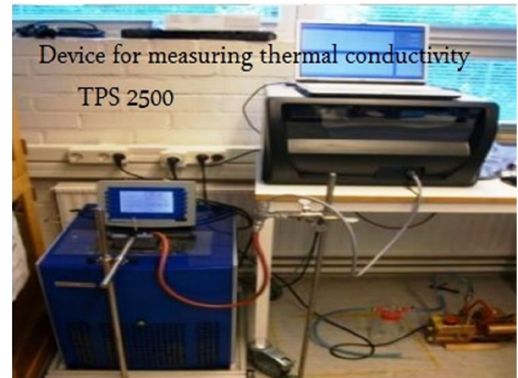
Fig. 2: Thermo-physical Fig.2:Thermo-physical analyzers